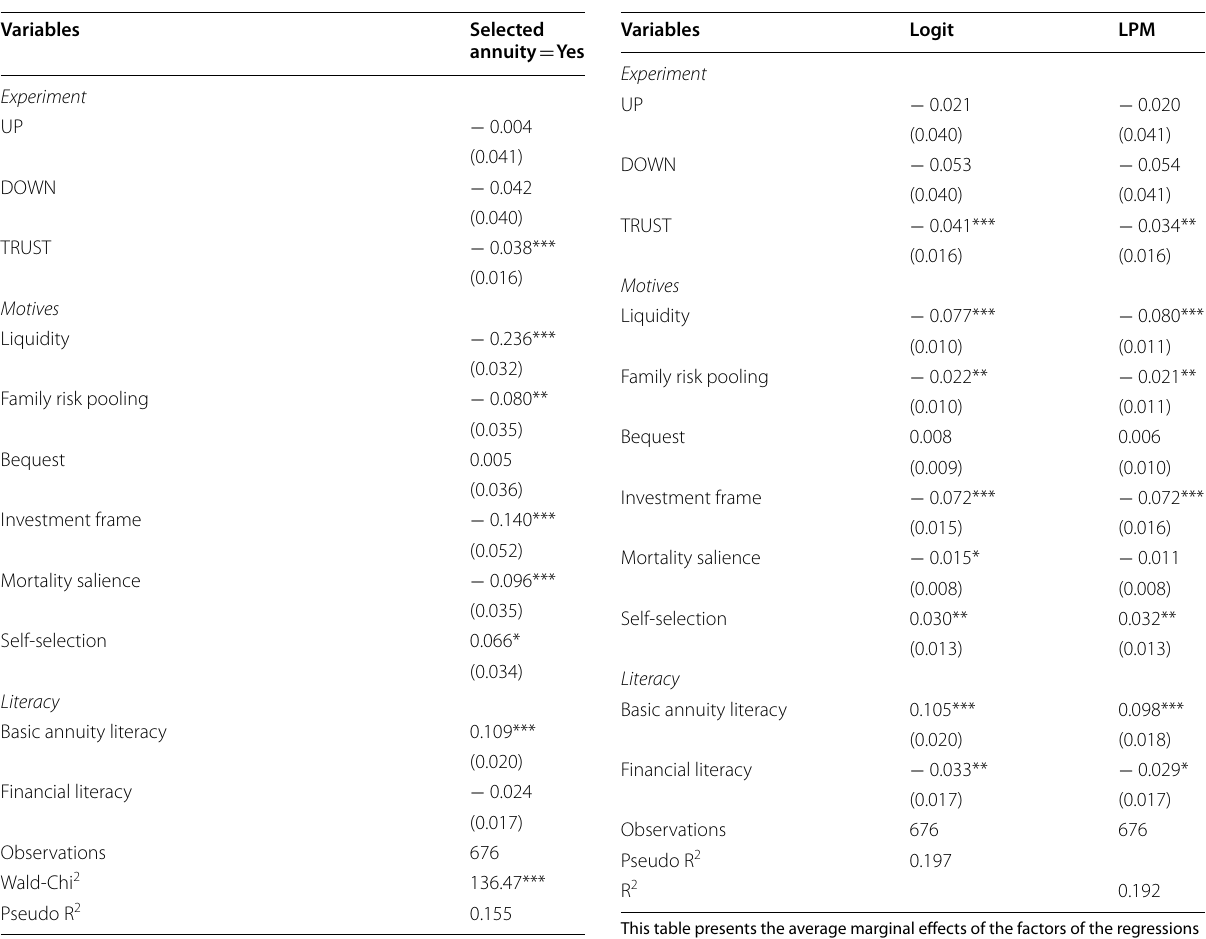
Table 7 Average marginal effects with median-split motives variables